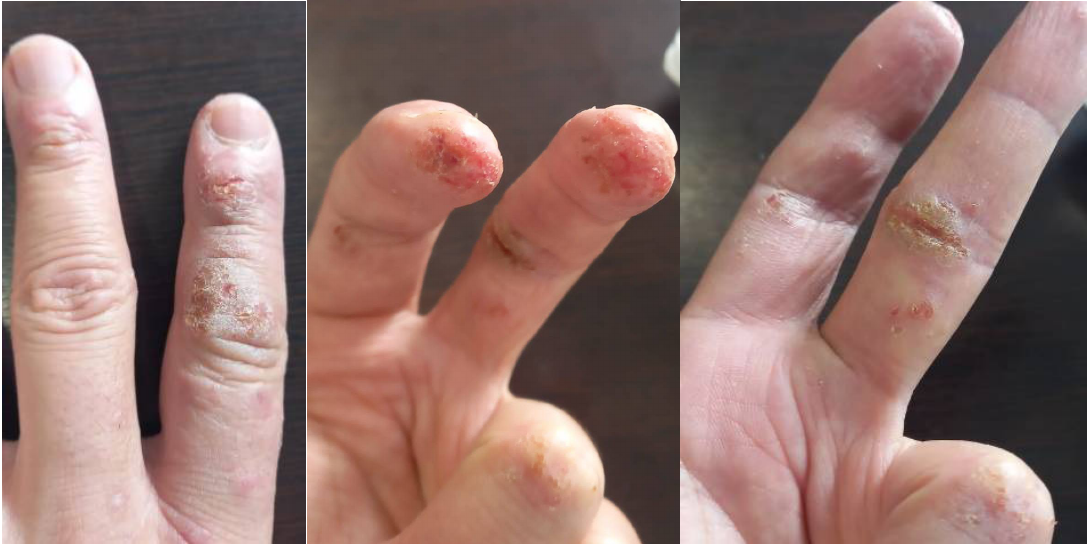
Figure 1. Occupational allergic contact dermatitis on the hand of a 35-year-old hairdresser.